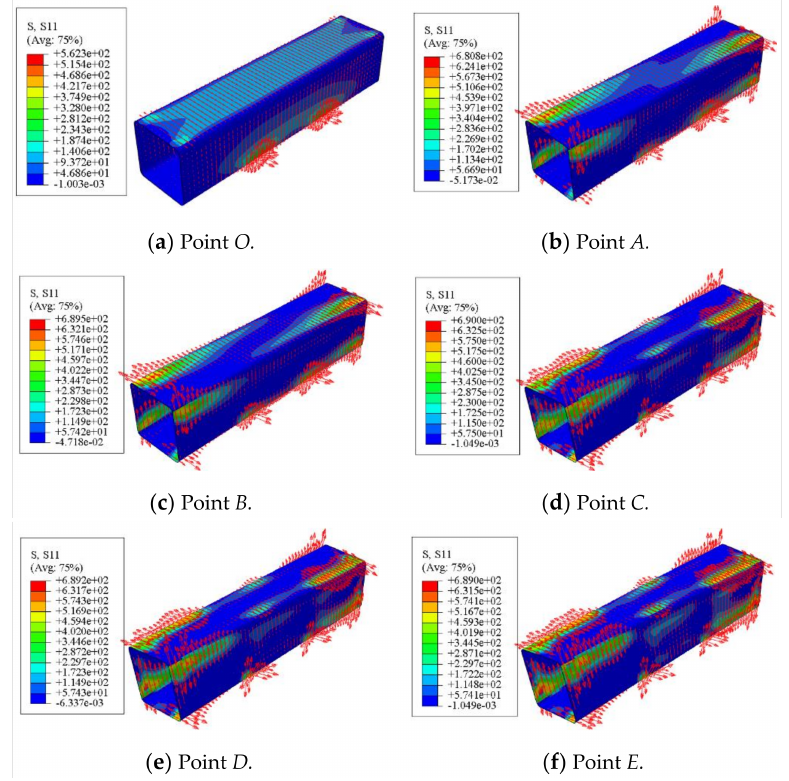
Figure 18. Stress distribution of transverse CFRP.